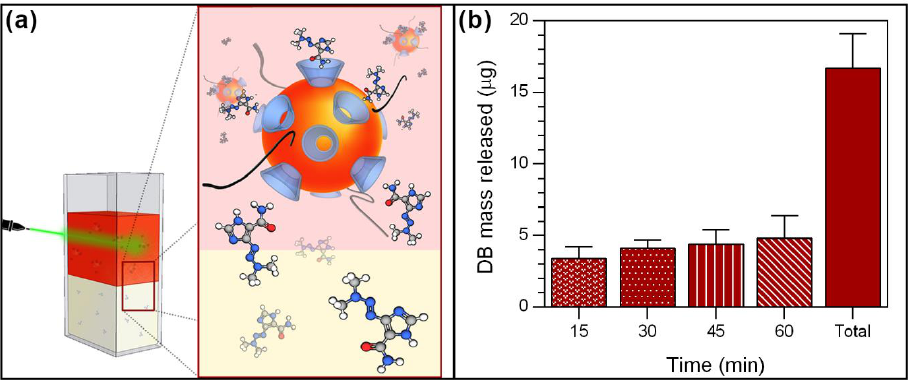
Figure 6. ( a ) A schematic representation of the setup used to irradiate the nanosystem using a laser at 532 nm. ( b ) Average mass of DB released at different time intervals and in total using laser irradiation on the PEG-AuNPs- βCD@DB nanosystem.